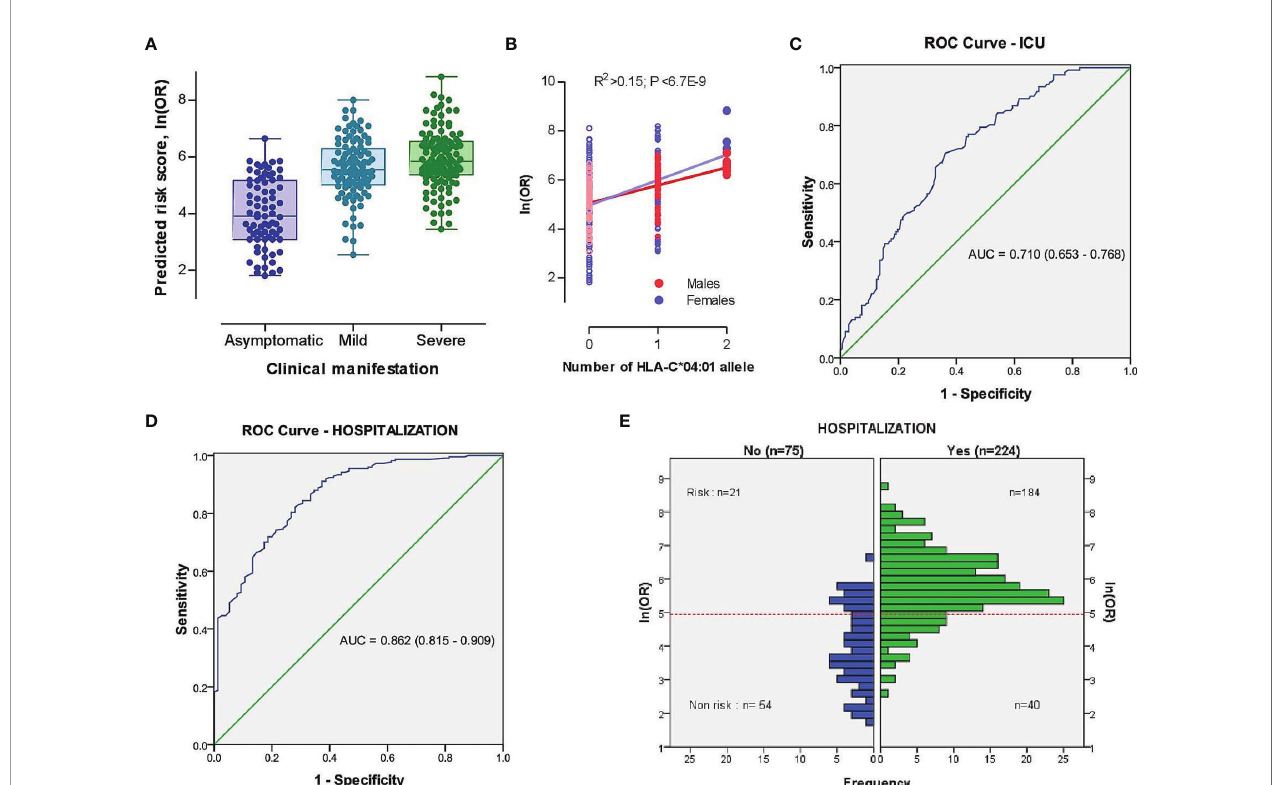
FIGURE 3 | The model characteristics for prediction of the risk scores between severe (ICU-admitted) and non-severe, as well as hospitalized and non-hospitalized COVID-19 cases. (A) Distribution of risk scores in different subsets of COVID-19 cases based on the clinical picture. (B) Distribution of risk scores in different subsets of COVID-19 cases based on the genomic number of HLA-C*04:01 allele. P-value was driven from Pearson correlation test. (C, D) Receiver operating characteristic (ROC) curve involving the contribution of HLA-C*04:01, sex, and sex-dependent age effects for discrimination of severe vs. non-severe (C) and hospitalized vs. non- hospitalized (D) COVID-19 cases. True positive rate (sensitivity) was plotted against false positive rate (1-speci fi city). The areas under the curves are presented for each outcome. (E) Histogram plot of hospitalized and non-hospitalized cases versus distribution of ln(OR). The dotted red line represents the threshold of the plot obtained from the AUC (Area Under Curve) with optimal sensitivity (0.821) and speci fi city (0.720). A signi fi cant difference was observed between risk and non-risk cases (OR (95% CI) = 11.83 [6.43-21.75],